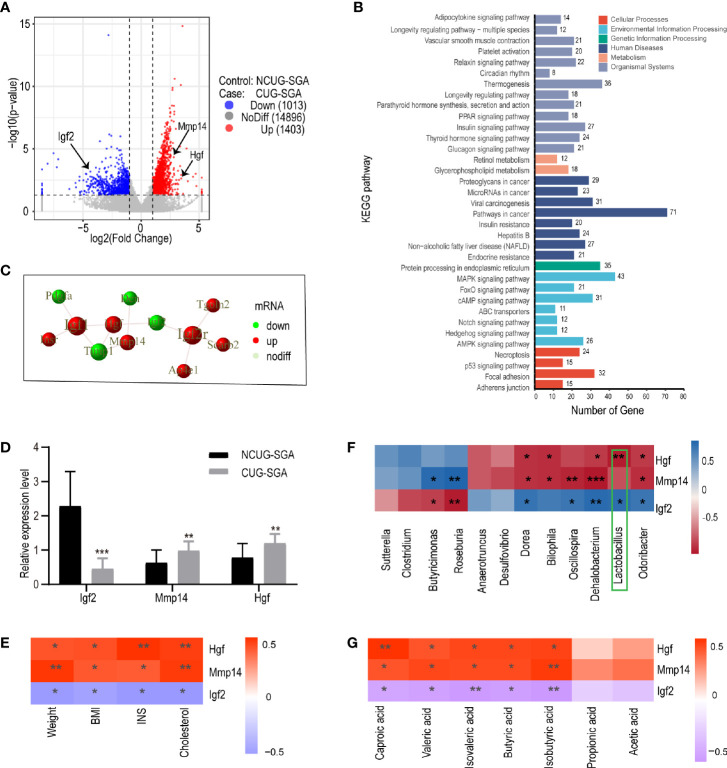
Transcriptome sequencing, validation, and correlation analysis of metabolism-related genes with microbiota and clinical indicators in liver tissues of rats from NCUG-SGA (n=5) and CUG-SGA (n=5) groups (A) Volcano plots of differentially expressed genes (DEGs) with |log2FoldChange|>1 and P value<0.05; (B) KEGG pathways of DEGs; (C) the protein-protein interaction (PPI) of Igf2, Mmp14, and Hgf; (D) qRT-PCR validation of metabolism-related genes; (E) Correlation analysis between metabolism-related genes and clinical indicators; (F) Correlation analysis between metabolism-related genes and microbiota at genus level; (G) Correlation analysis between metabolism-related genes and SCFA. *P < 0.05, **P <0.01, ***P< 0.001.